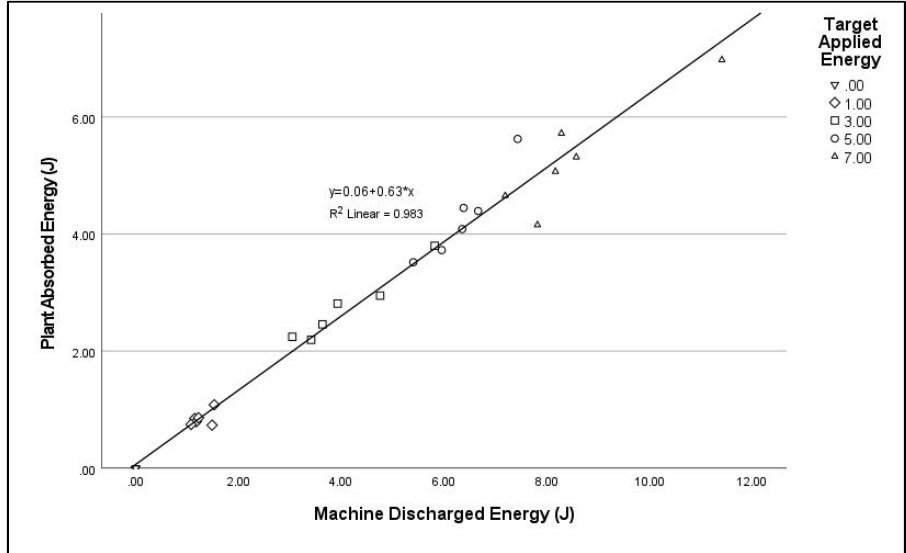
Figure 9. Scatterplot of energy absorbed by above ground plant tissue when Solanum nigrum seedlings were treated with pulsed micro-shocks at 3.5 kV .